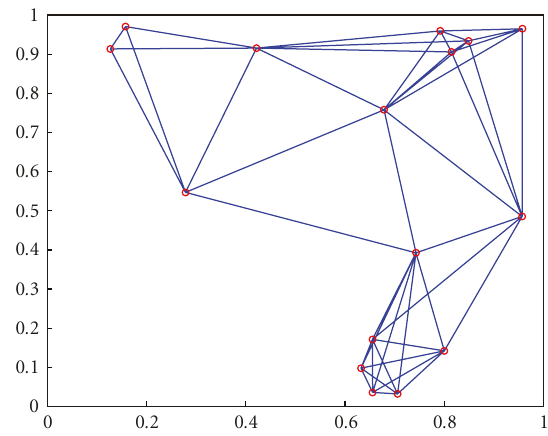
Figure 7: Random network with 16 nodes used to obtain simula- tion results in Figure